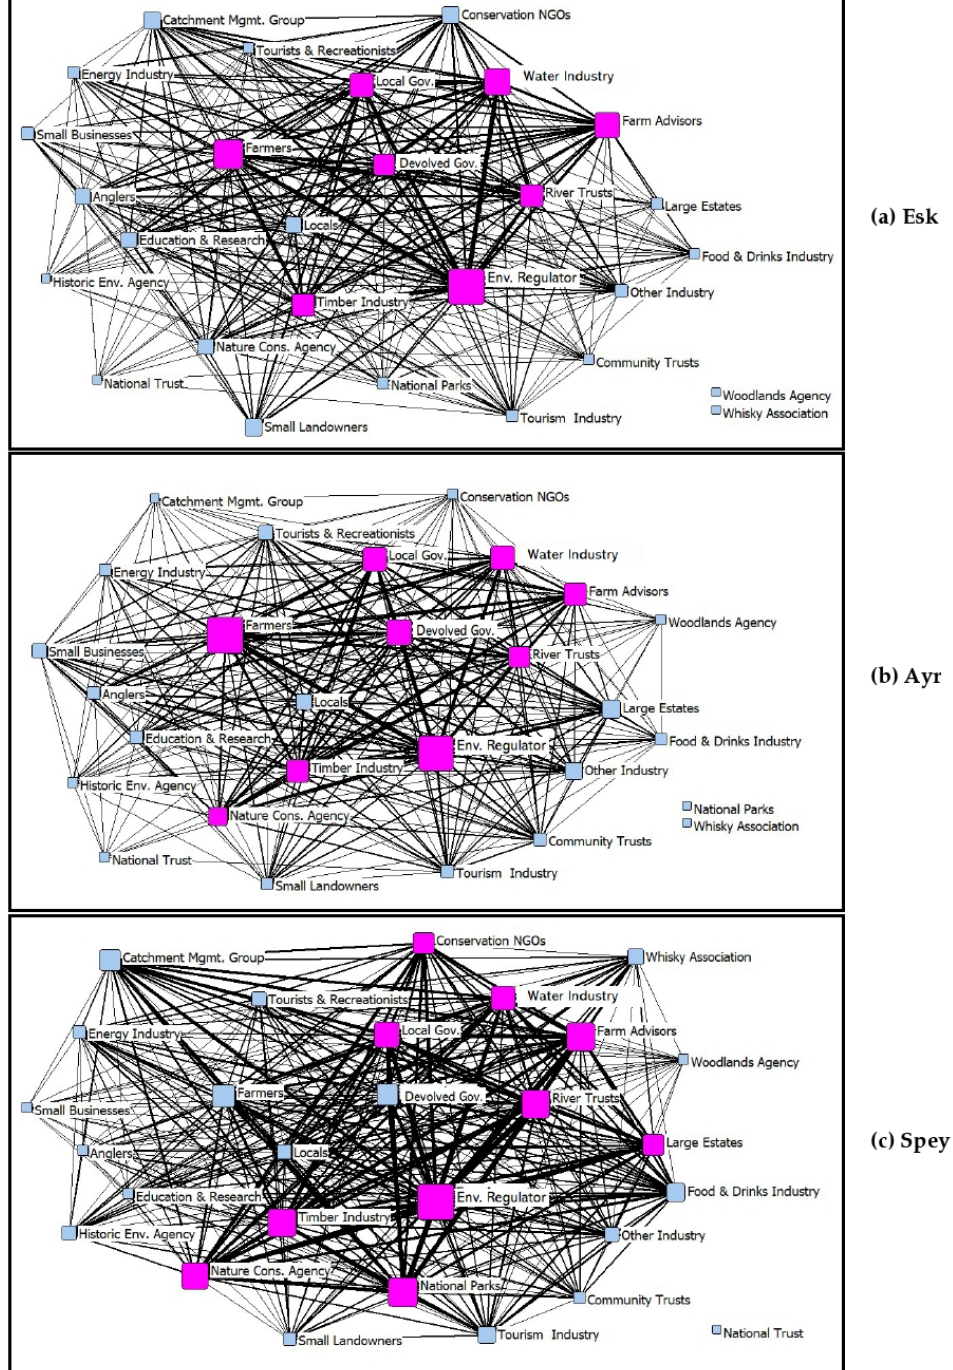
Figure 5. One-mode networks from the ( a ) South Esk, ( b ) Ayr and ( c ) Spey catchments. Node size depicts degree score and node colour the core (pink) and periphery (blue). Core/Periphery fit (correlation) = 0.889 (South Esk), 0.912 (Ayr) and 0.897 (Spey).